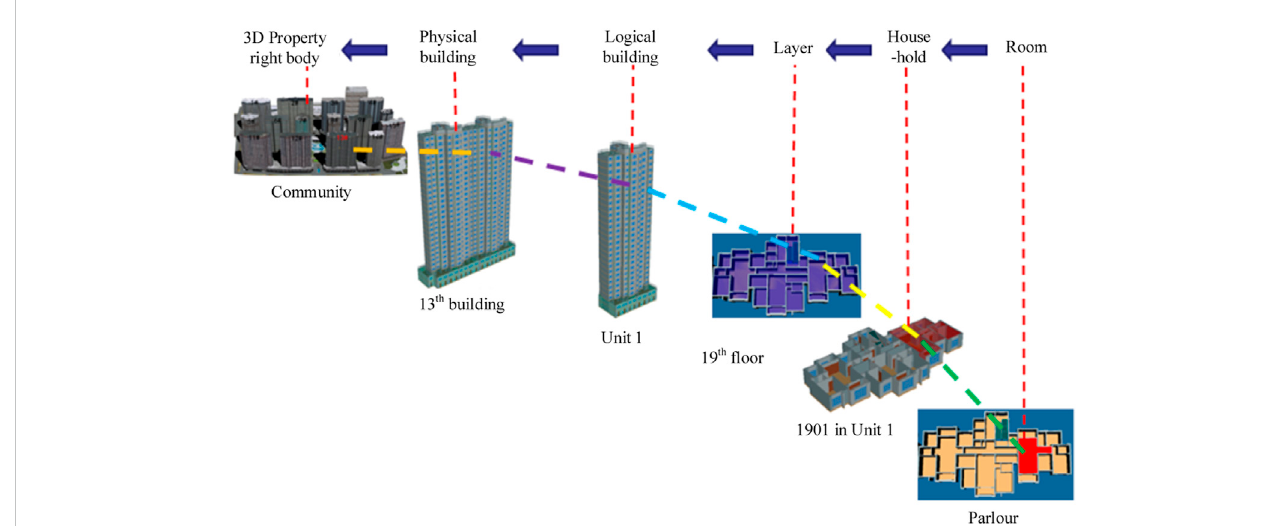
FIGURE 8 Schematic diagram of property right space generation with multi-level structure.